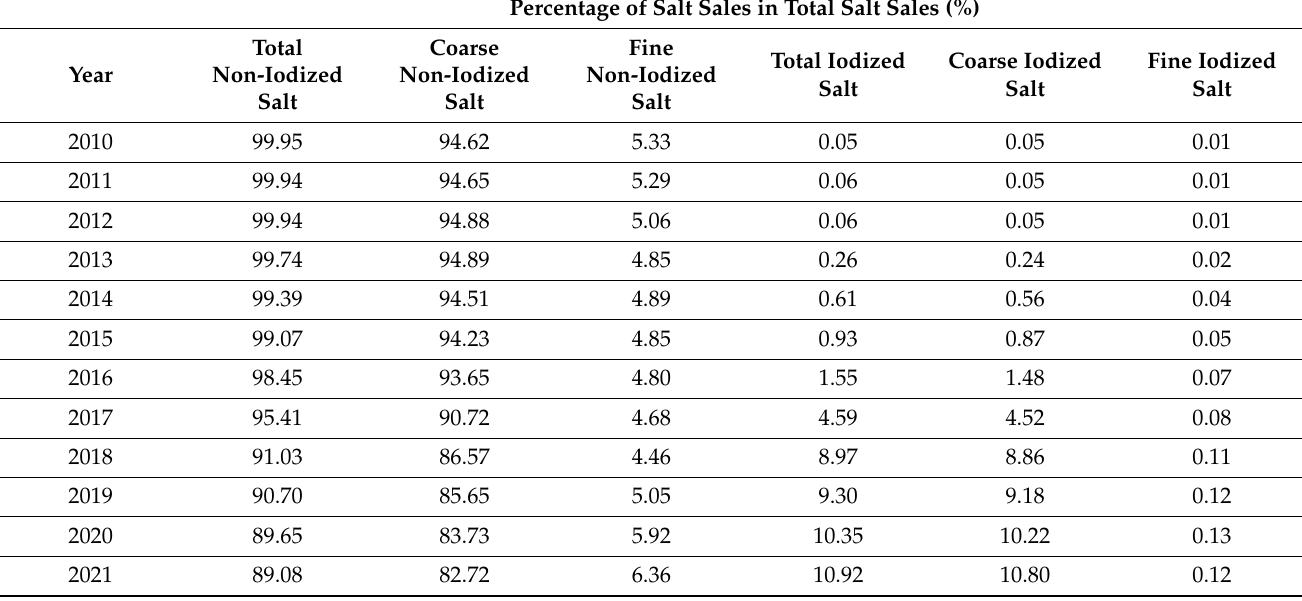
Table 2. Percentage of salt sales in total salt sales (%) from 2010 to